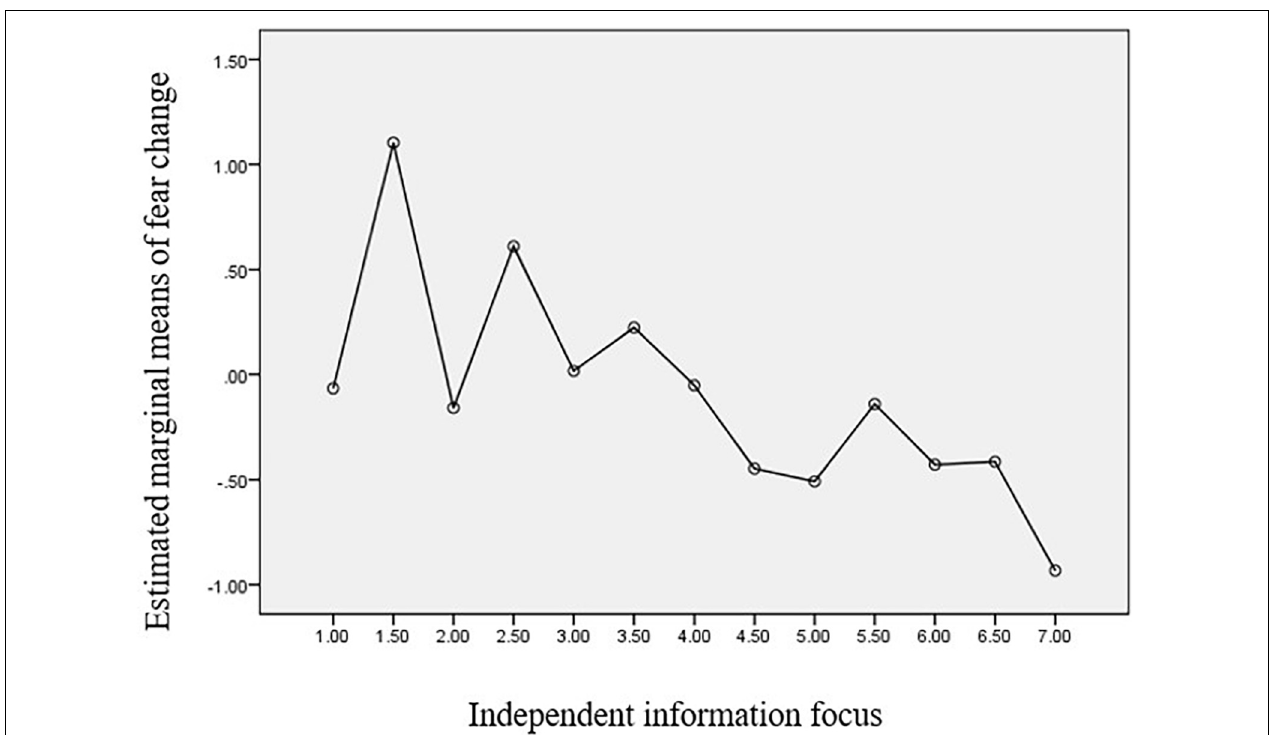
FIGURE 2 | Estimated Marginal Means of Fear Change.